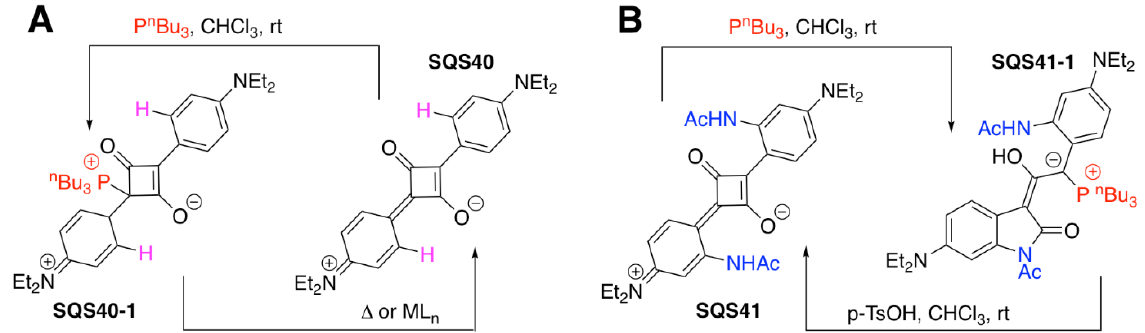
Scheme 16. Representative examples of relays that feature phosphine additions to squaraine scaffolds ( A ): SQS40 [113] and and ( B ): SQS41 [114]. ( B ): SQS41